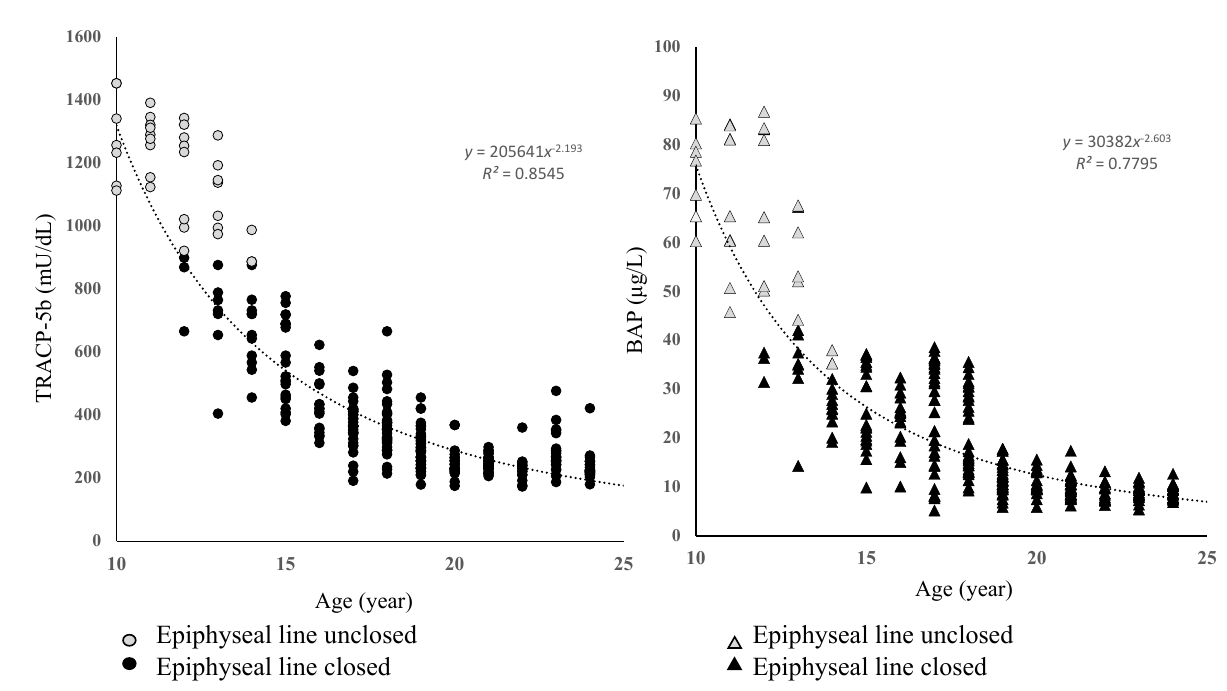
Figure 1. Age–specific distribution of bone metabolism markers.